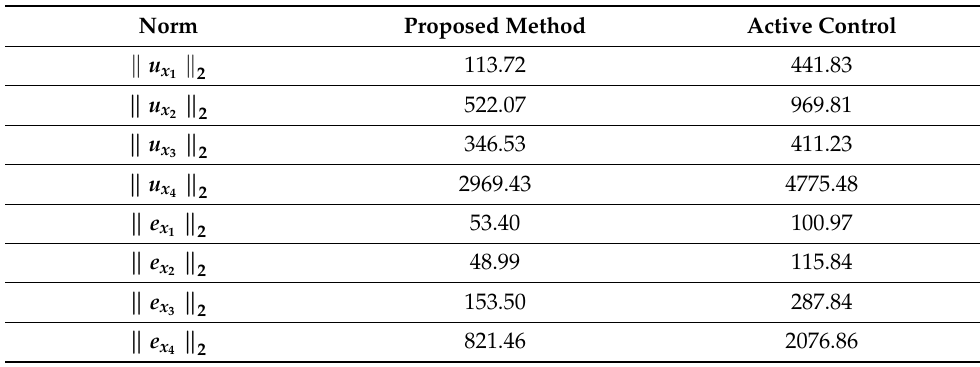
Table 2. The norm of synchronization errors and control